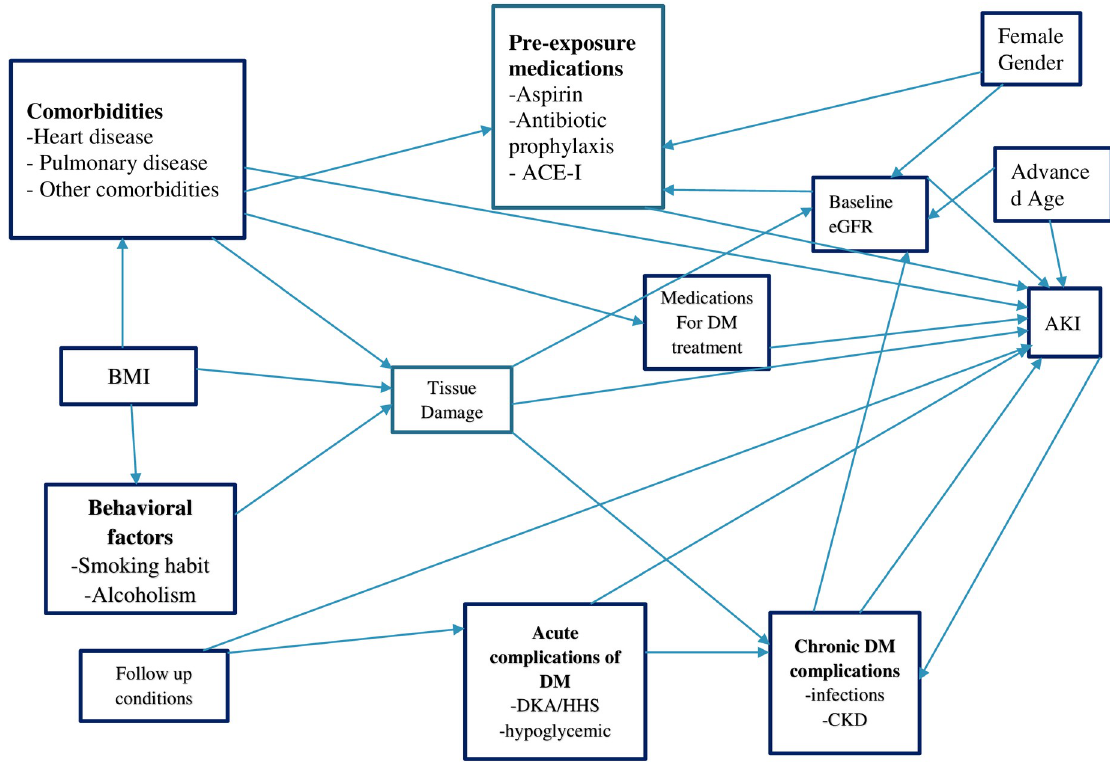
Fig 1. Direct acyclic graph for the risk factors of AKI among type 2 diabetes patients (Source: (Kasper 2005, Khwaja 2012, Lameire, Bagga et al. 2013, Lee 2015).